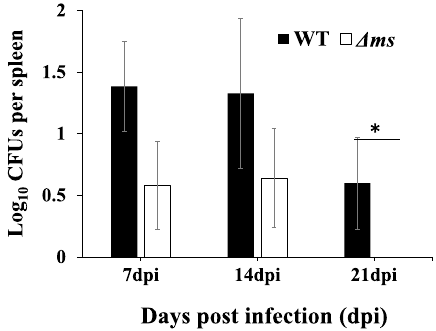
Figure 4. Quantitation of bacterial burden in the spleen upon oral infection of birds with WT or Δ ms strains of S. Typhimurium : the spleen was homogenized in sterile PBS and 100 μl homogenate was plated on HEA plates. The CFU per spleen was calculated after 7 and 14 days post infection (dpi). The data are presented as mean ± SE (n = 5). * p < 0.05.